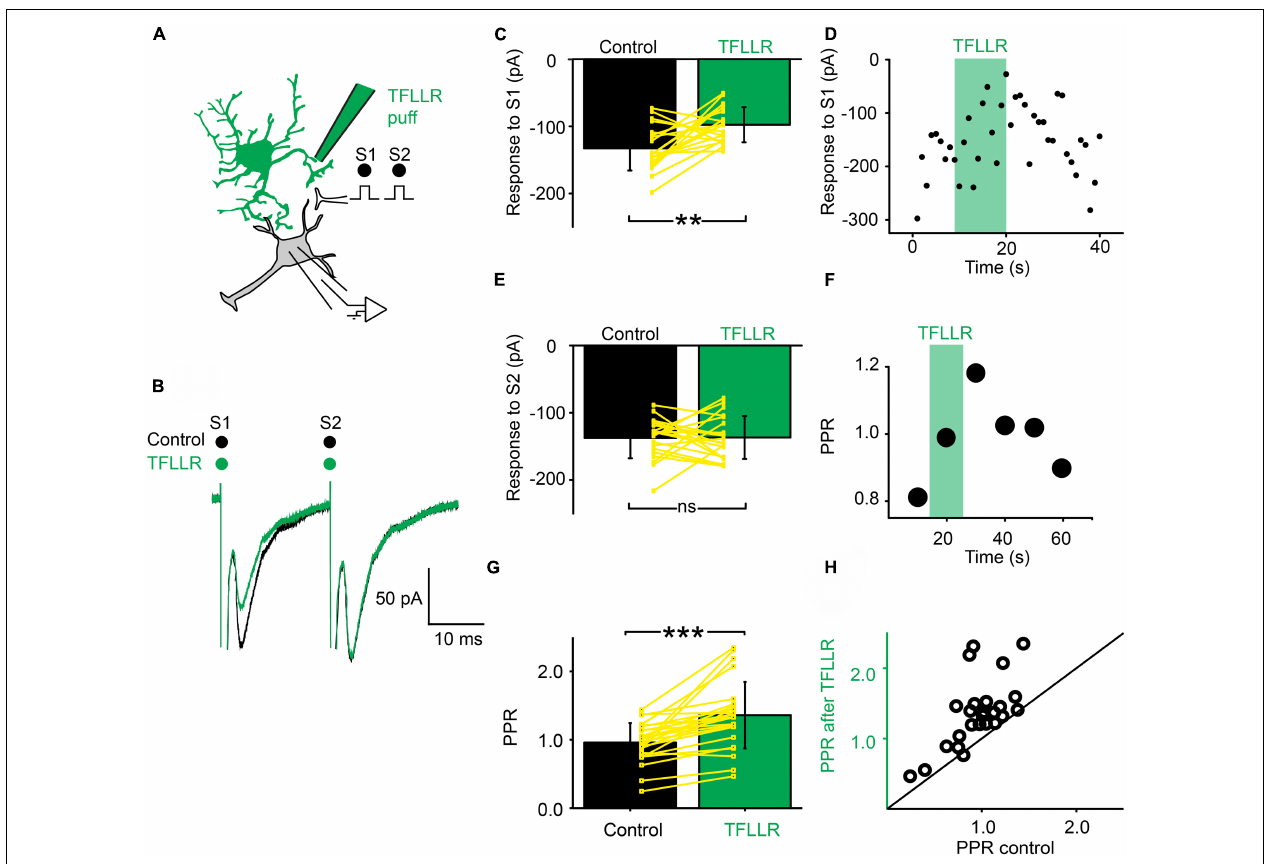
(D) Amplitude of the first EPSC before, during (green bar) and after puffing TFLLR. Note the decrease in amplitude during the puff. (E) Amplitude of the second EPSC in control conditions and after puffing TFLLR. (F) Time course of the changes occurring for the PPR calculated for the neuron recorded in (B). TFLLR increased the PPR. (G) Mean PPR for all the cells recorded before and after puffing TFLLR. The yellow lines correspond to individual values. The PPR was significantly increased. ∗∗∗ p < 0.001. (H) PPR after TFLLR in one astrocyte as a function of PPR in control conditions. Most points are above the line of equality.